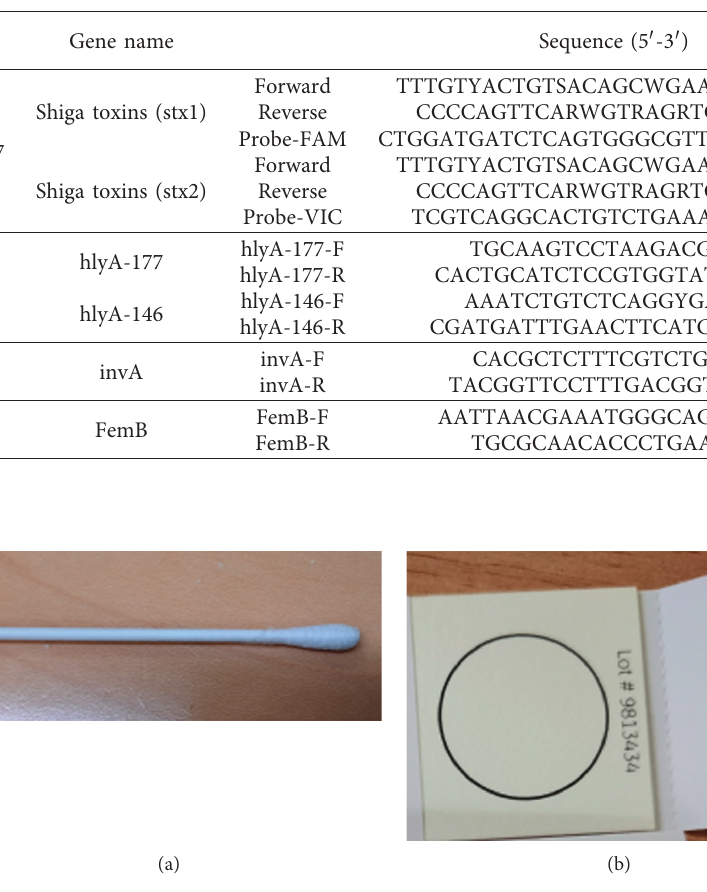
Table 1: Primers used in the